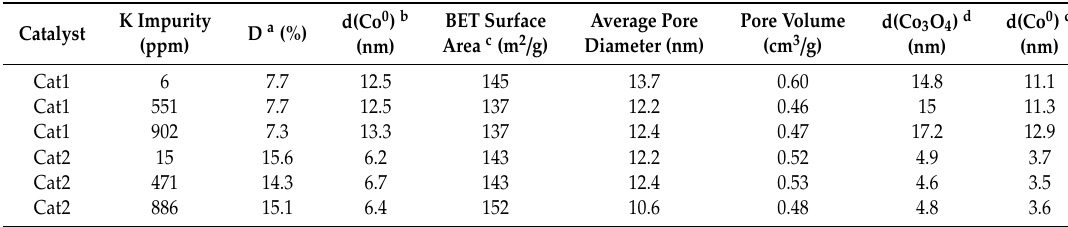
Table 1. Characterization